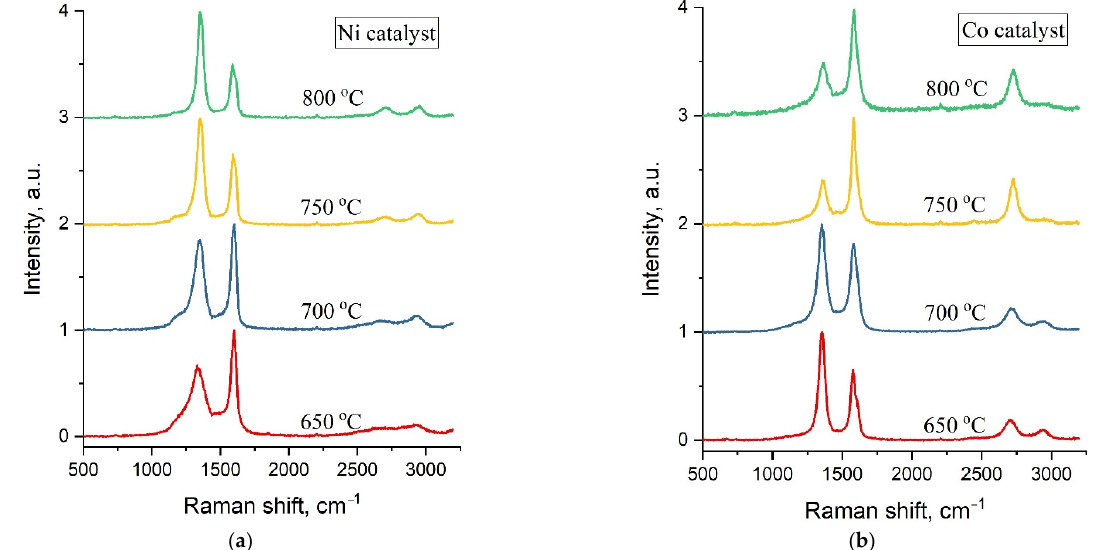
Figure 4. Raman spectra of carbon samples synthesized using ( a ) Ni and ( b ) Co catalysts at different temperatures.